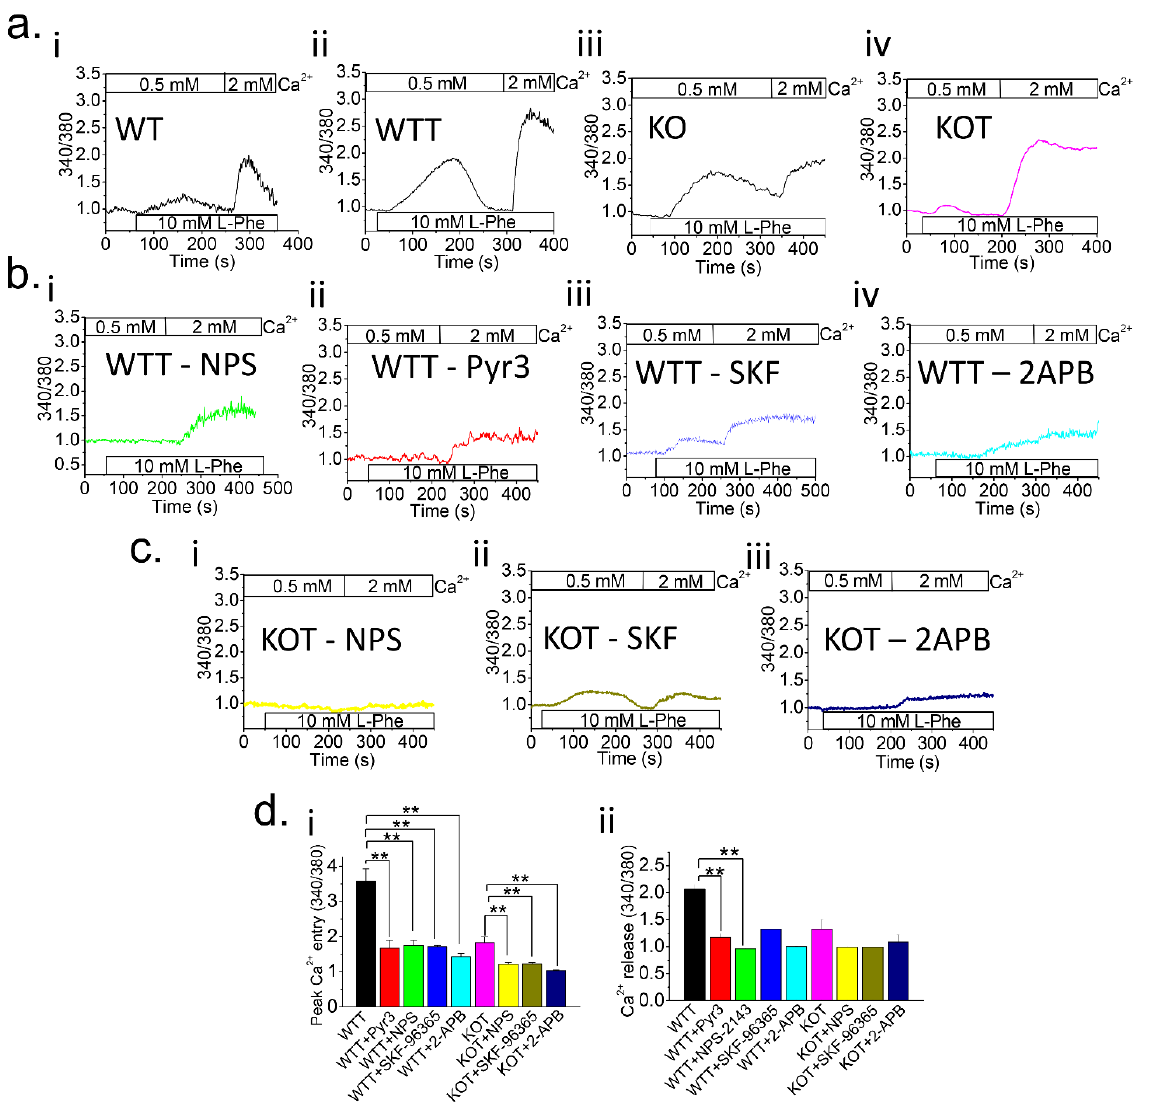
Figure 1. Higher luminal pH in TRPC KO PT cells enhances Ca 2+ entry. [Ca 2+ ] i measurements were performed on Fura-2 loaded ( a ) control PT cells and ( b,c ) PT cells with NPS-2143 (NPS; 1 µ M), Pyr3 (3 µ M), SKF-96365 (SKF; 10 µ M) or 2-APB (12 µ M) inhibitors from WT, Acz-treated WT (WTT), TRPC3-/- (KO), or Acz-treated KO (KOT) mice. Prior to experiments, PT cells were placed in 0.5 mM Ca 2+ bath and L-Phenylalanine (L-Phe; 10 mM) was applied. Subsequently, 2 mM Ca 2+ was applied to replenish [Ca 2+ ] o . Fura-2 trace measurements were plotted for ( ai ) WT, ( aii ) WTT, ( aiii ) KO, and ( aiv ) KOT; WTT PT cells with ( bi ) NPS, ( bii ) Pyr3, ( biii ) SKF, and ( biv ) 2-APB inhibitors; and KOT PT cells with ( ci ) NPS, ( cii ) SKF, and ( ciii ) 2-APB inhibitors. ( di , dii ) Peak Ca 2+ entry and Ca 2+ release were quantified with representative bar diagrams in means ± SEM, respectively. Each experiment was performed four times. **, p < 0.01.